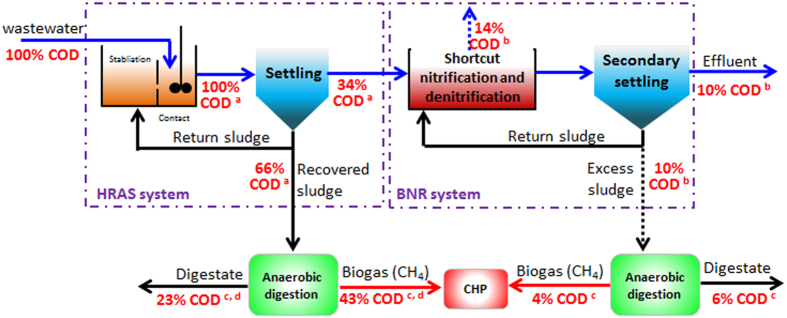
COD flow in A-B process with HRAS as A-stage and shortcut nitrification and denitrification as B-stage; (a) data from Meerburg et al.26; (b) data from Metcalf and Eddy12; (c) data from Parkin and Owen47; (d) data from Miron et al.48.